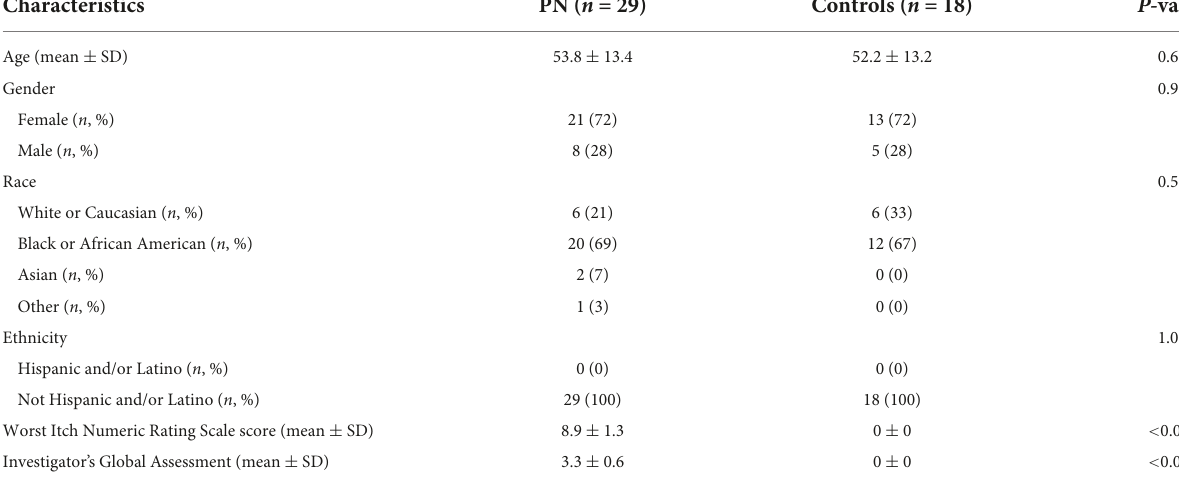
TABLE 1 Baseline demographics of